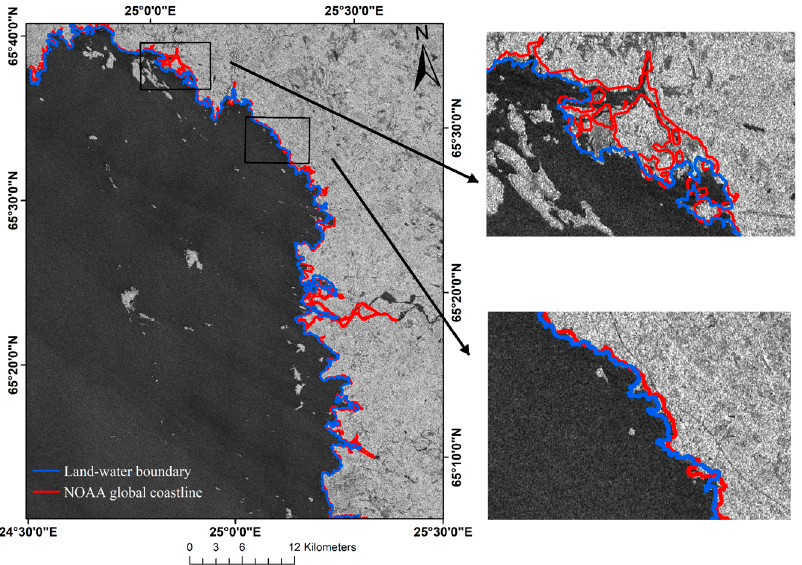
Figure 11. Comparison of the land–water boundary. The blue and red solid lines represent the land-water boundary and NOAA global coastline, respectively. Table 3. Statistical parameters of the land–water